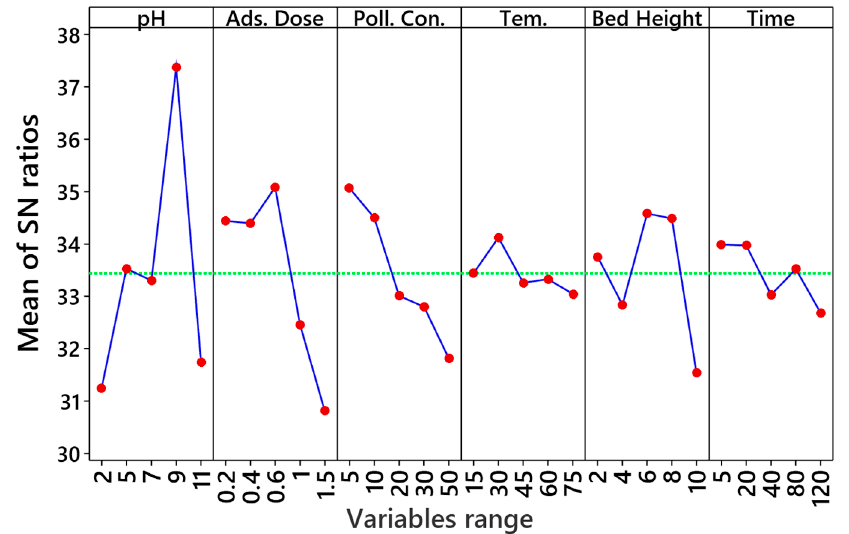
Figure 6. Signal-to-noise ratios of different experimental parameters of the SMT adsorp- tion process (Ads: Adsorption, Poll. Con.: Pollution Concentration, Tem.: Temperature). (Ads: Adsorption, Poll. Con.: Pollution Concentration, Tem.: